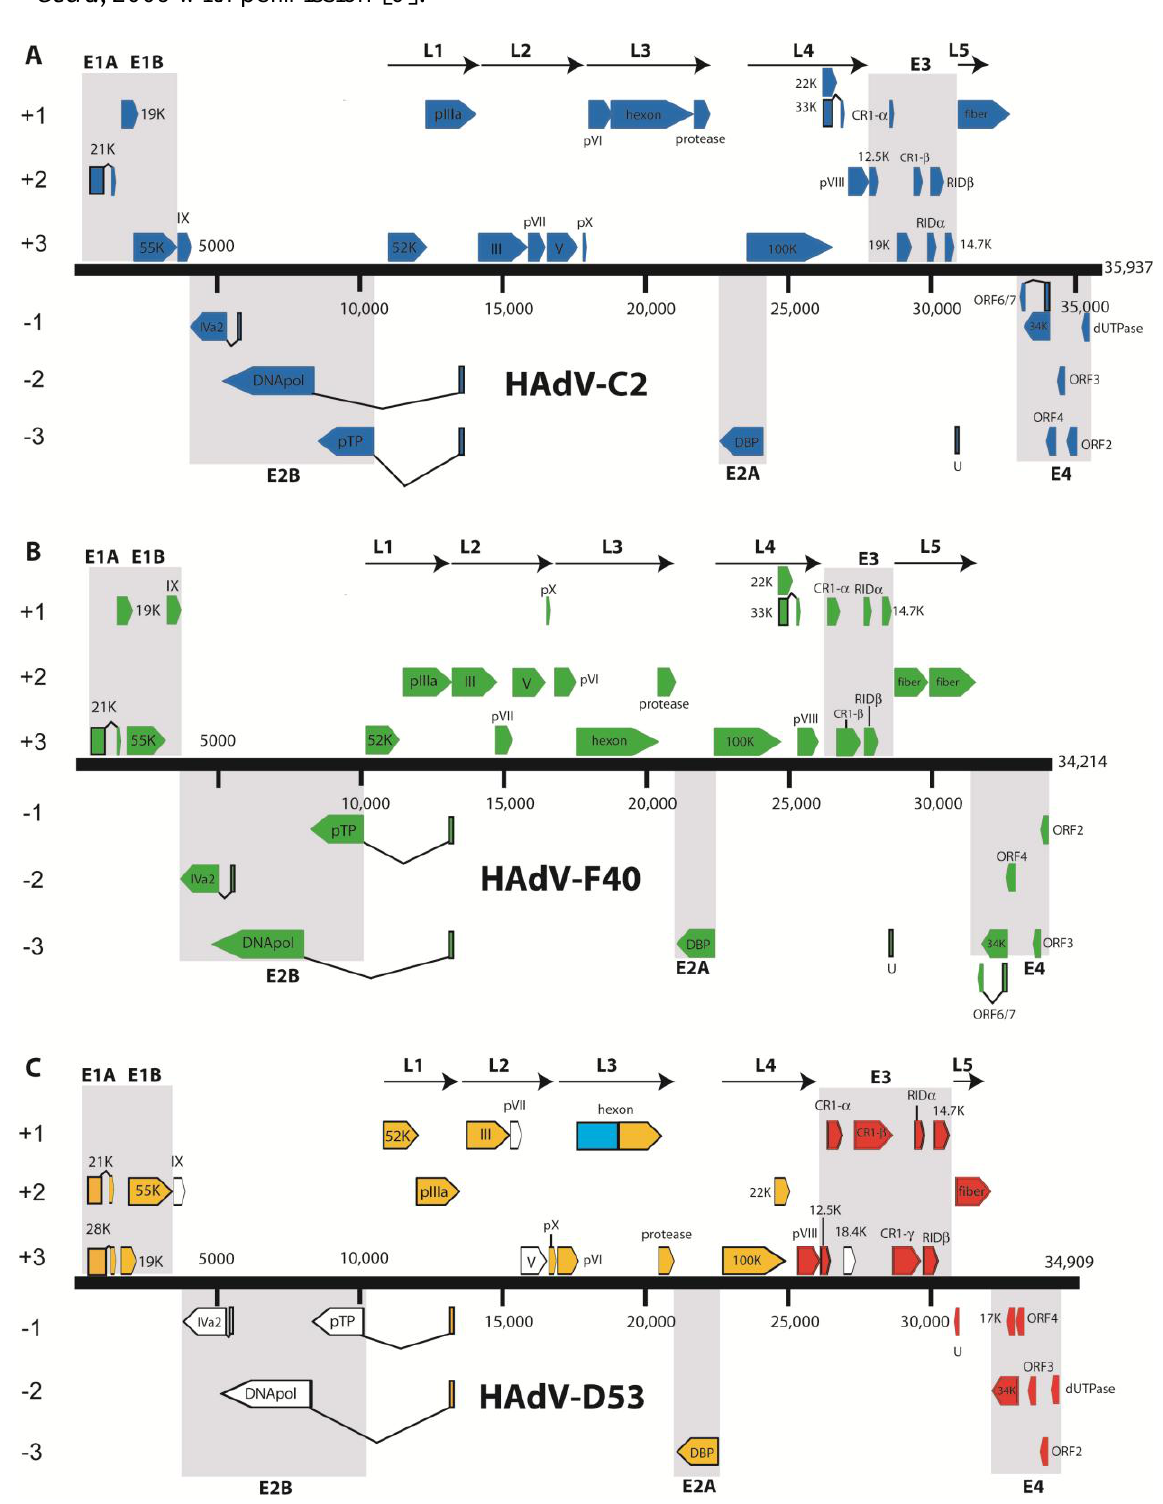
Figure 2. Transcriptional map and genome organization of HAdV-C2, HAdV-F40, and HAdV-D53. Genomes are represented by a central black horizontal line marked at 5-kbp intervals. Protein encoding regions are shown as boxes. Boxes above the black line represent open reading frames (ORFs) that are encoded on the forward (or upper) strand. Boxes underneath the black line represent ORFs that are encoded on the reverse (or lower) strand. (a) HAdV-C2. (b) HAdV-F40. (c) HAdV-D53. Figure 2B was adapted from Walsh et al ., 2009 with permission